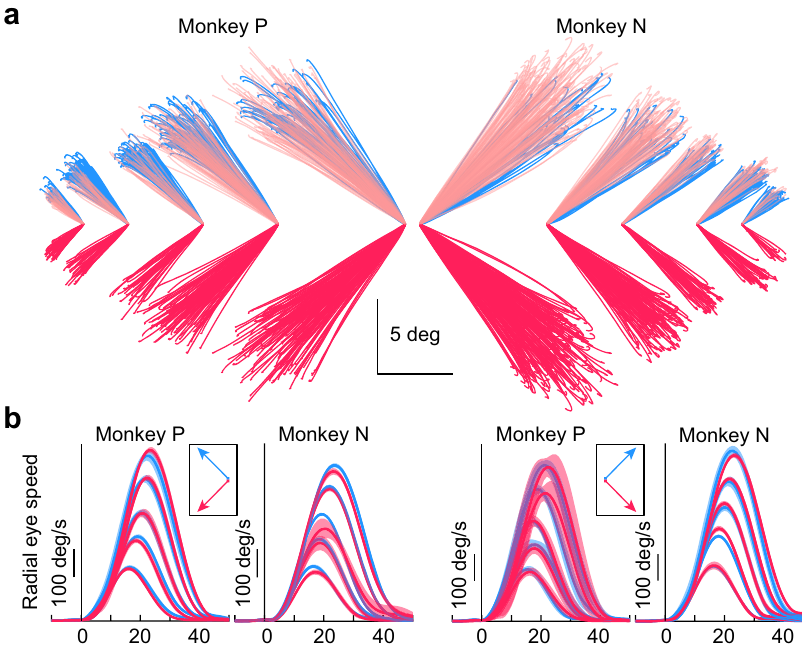
Fig. 2 Upward and downward oblique saccades from the same sessions as the neural recordings exhibited similar kinematic properties, despite the neural asymmetry. a Oblique saccades of different directions and amplitudes in both monkeys (rightward for N and leftward for P). Each line plots the horizontal and vertical displacement of eye position for a given saccade having a + 45 deg (light blue) or − 45 deg (light red) direction from the horizontal meridian. Saccades of similar sizes are grouped together (to start from the same origin) and displaced horizontally in the fi gure from saccades of different size ranges (the scale bars apply to all sizes). The pink traces overlaying the light blue traces are the same as the light red traces of the lower visual fi eld saccades, but now re fl ected along the vertical dimension for better comparison to the upper visual fi eld saccades. The trajectories of the saccades were largely similar regardless of direction from the horizontal meridian, despite the asymmetry in motor bursts in Fig. 1. b For each monkey, we plotted radial eye speed as a function of time from saccade onset for leftward (left pair of plots) or rightward (right pair of plots) saccades. In each case, we separated upward and downward movements by color (as in a ). The different saccade sizes in a are re fl ected in the different peak speeds 34, 35 . The kinematic time courses of saccade acceleration, peak speed, and deceleration were largely similar for upward and downward saccades, despite the asymmetry of SC motor bursts in Fig. 1. Error bars denote 95% con fi dence intervals. The numbers of trials per condition in monkey N ranged from 7 to 362 (mean 121.2), and the numbers of trials per condition in monkey P ranged from 5 to 252 (mean 72.25).